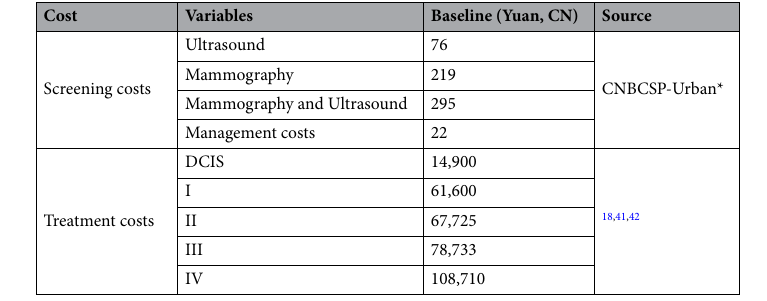
Table 2. Related cost parameters of Markov model in breast cancer screening. CNBCSP-Urban*—Data source form the breast cancer screening program in Urban Hebei.